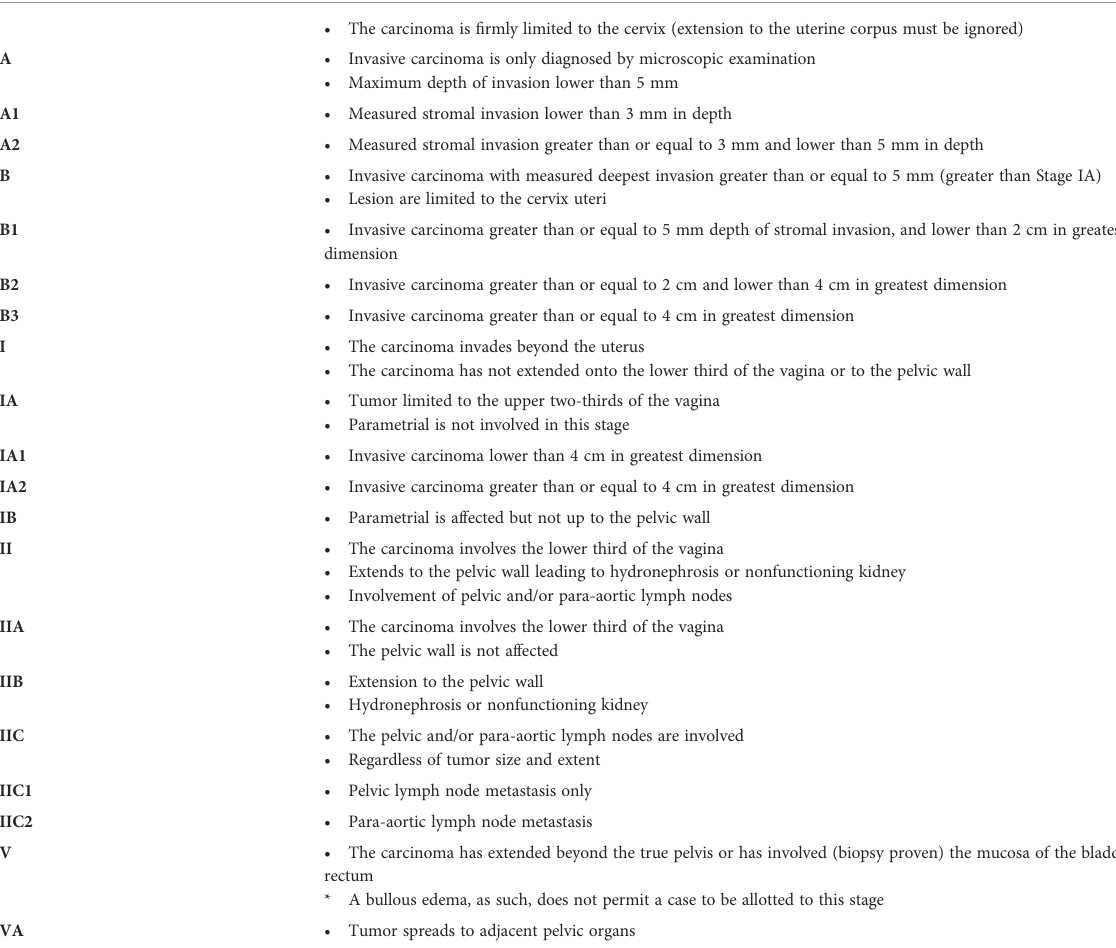
TABLE 1 FIGO staging of cervical cancer (2018). Stage